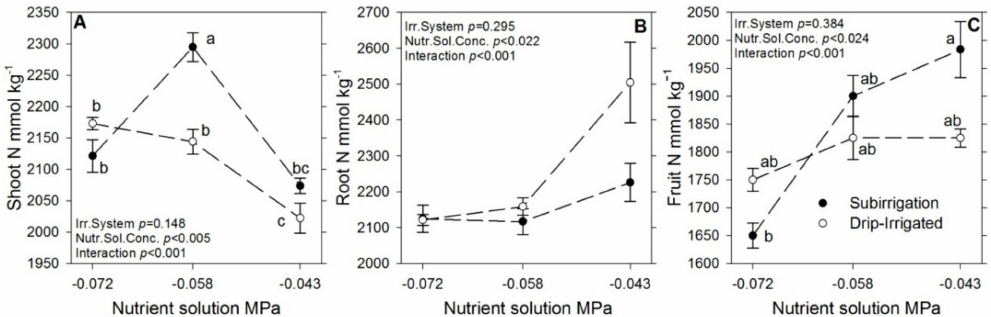
Figure 4. ( A – C ) Effect of the irrigation system and the concentration of the nutrient solution on nitrogen concentration in tomato ( Solanum lycopersicum L.) plants. ANOVA significance for both factors, irrigation system (Irr. System) and nutrient solution concentration (Nutr. Sol. Conc.), and the interaction is shown. Means with the same lower-case letter indicate non-significant differences according to Tukey’s multiple comparison test. Bars represent the standard error of the mean ( n = 4).